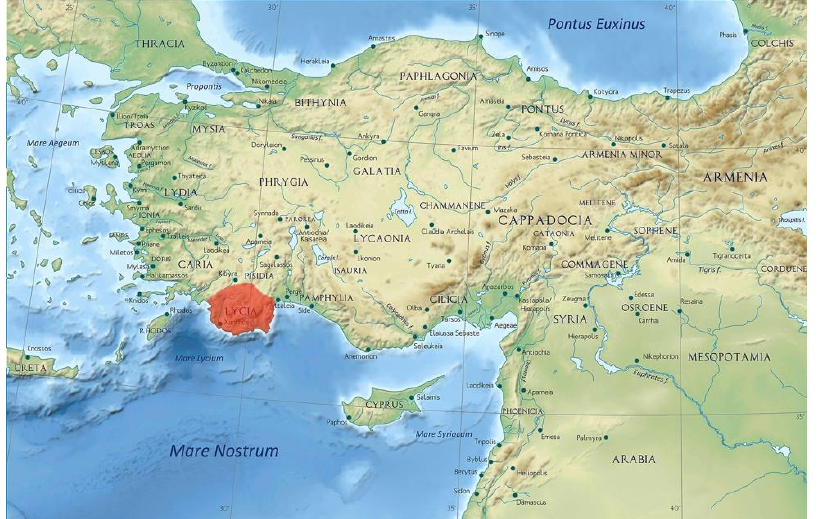
Figure 1. Map of Lycia (By Caliniuc—This file was derived from: Asia Minor in the Greco-Roman period—general map—regions and main settlements.jpg, CC BY-SA 4.0, https://commons.wikimedia.org/w/index.php?curid=74974031 accessed on 14 February 2021).